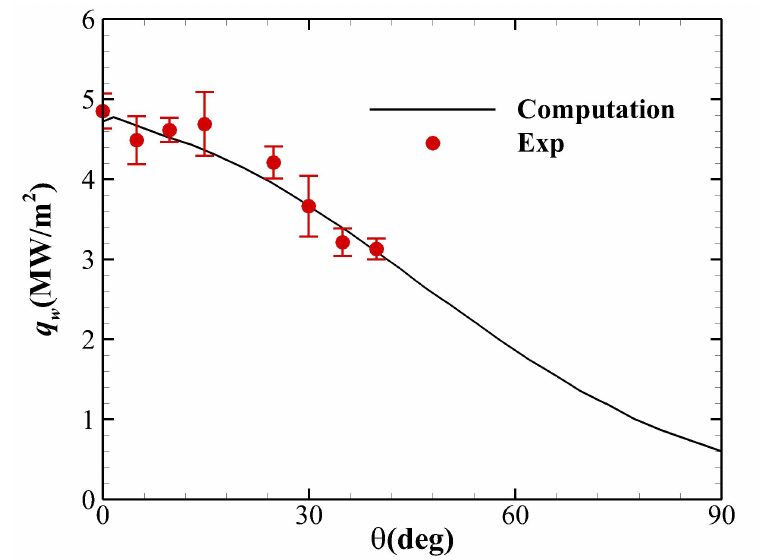
Figure 3. Comparison of measured and numerical result of surface heat flux.